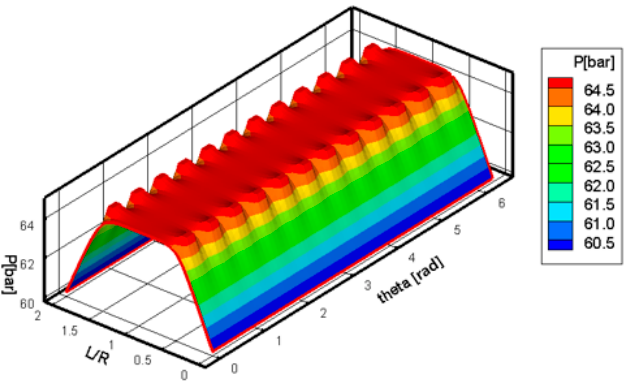
= 70 bar, p = 60 bar, ω = 21,000 e